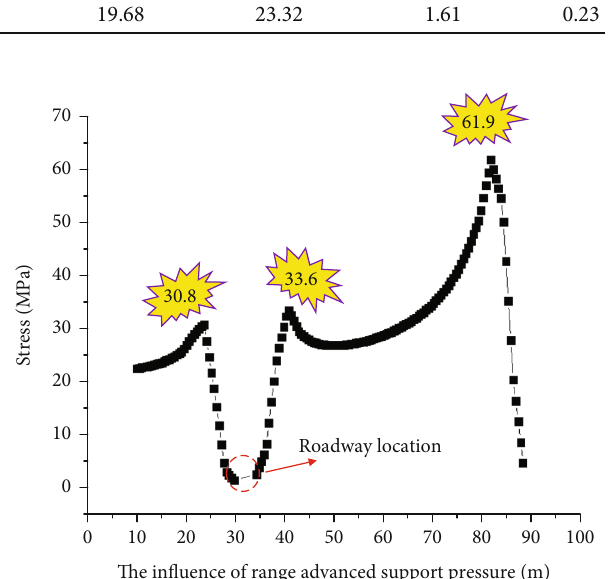
Figure 8: Advance abutment pressure